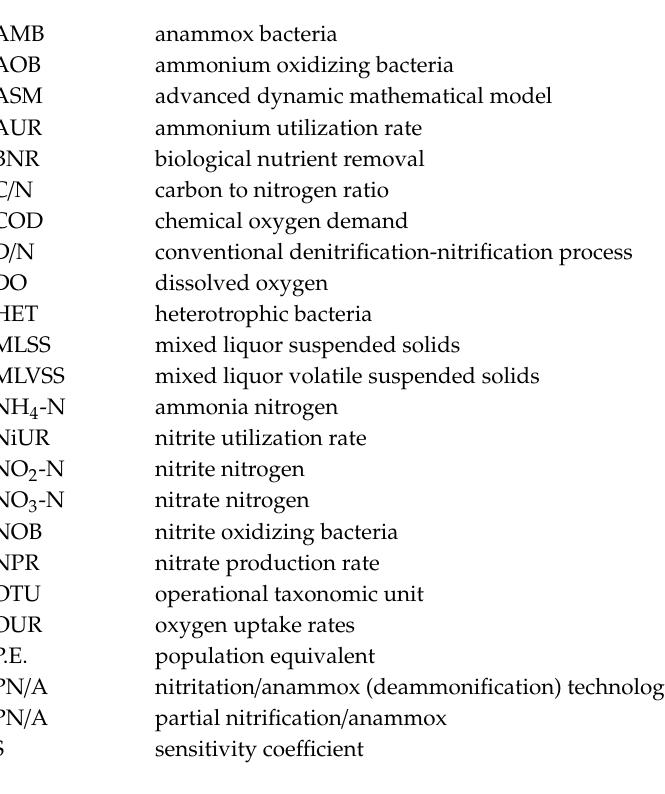
Figure S1: AUR and NPR under various combination of the temperature and dissolved DO set point, during batch tests with ammonium as a nitrogen source., Figure S2: NiUR and NPR under various combination of the temperature and dissolved DO set point, during batch tests with nitrite as a nitrogen source. Figure S3. DO profiles in the reactors during batch tests with ammonium as a nitrogen source under various temperatures and DO set points. Figure S4. DO profiles in the reactors during batch tests with nitrite as a nitrogen source under various temperatures and DO set points. Table S1. Averaged DO concentrations during batch tests with ammonium as a nitrogen source under various temperatures and DO set points. Table S2. Averaged DO concentrations during batch tests with nitrite as a nitrogen source under various temperatures and DO set points. Table S3. Identification of the most energy e ffi cient conditions in terms of AOB and NOB activity under various temperatures and DO set